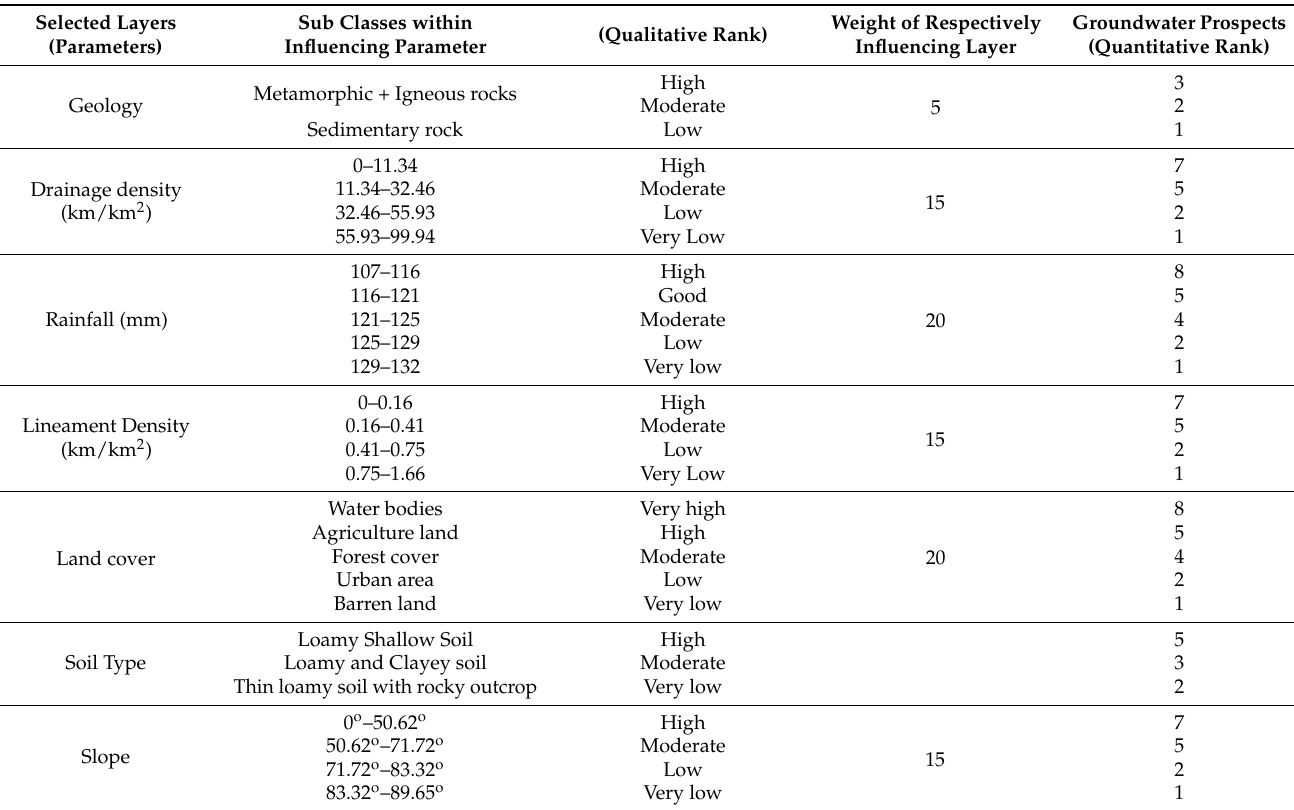
Weight of Respectively Groundwater Prospects (Qualitative Rank) Influencing Layer (Quantitative